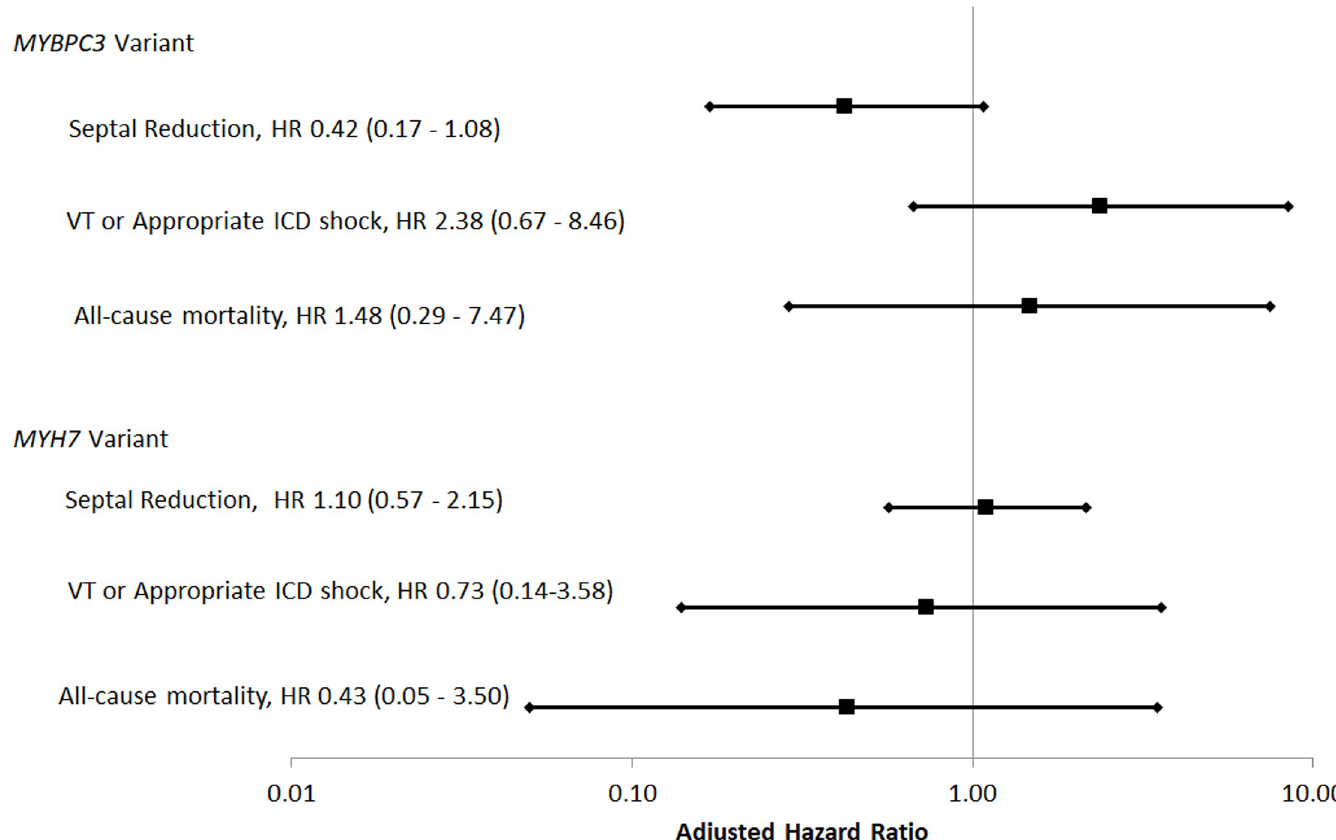
Fig 3. Summary of associations between clinical outcomes and genetic diagnosis. Note logarithmic scale.